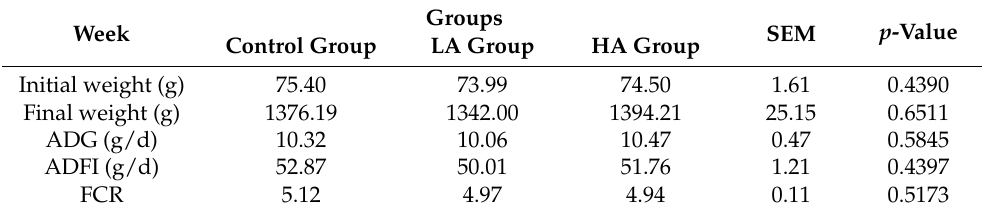
Table 3. Effects of dietary-supplemented Gynostemma pentaphyllum on the growth performance of laying hens at 2–20 weeks.